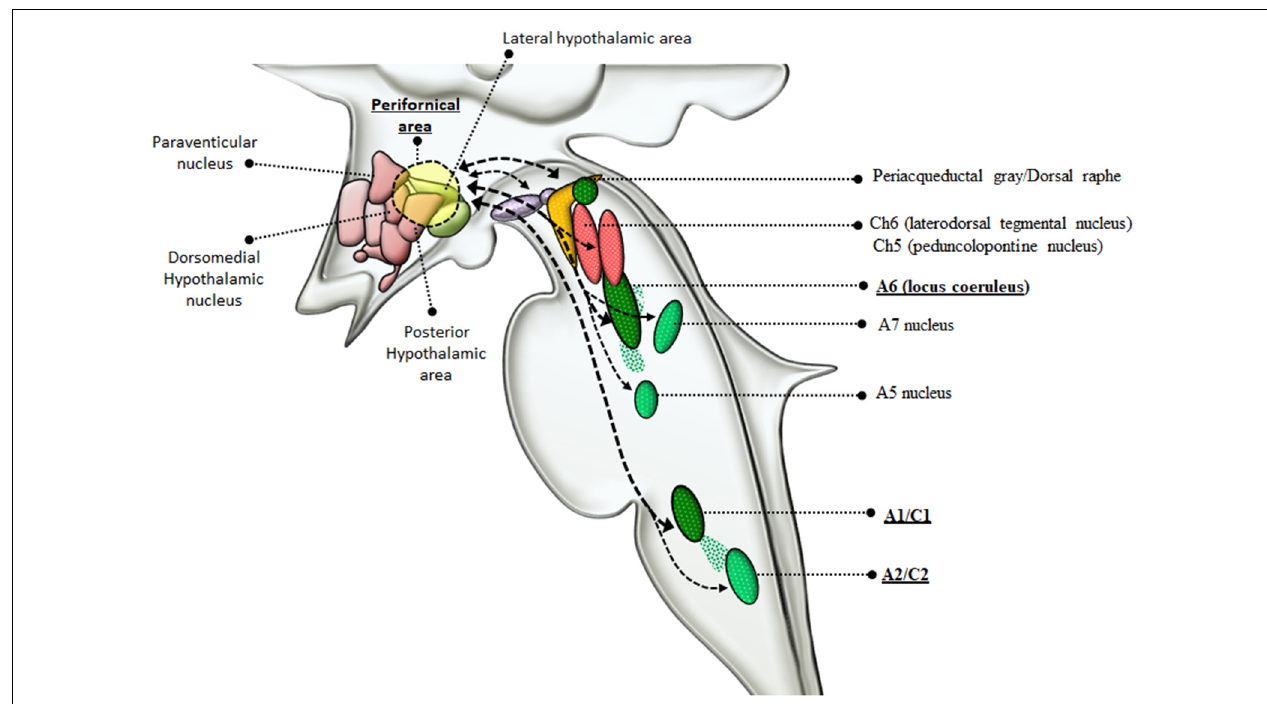
FIGURE 4 | Connections between reticular nuclei and orexin-containing perifornical neurons of the hypothalamus. Orexin-containing neurons are placed within the dorsolateral hypothalamus corresponding to the perifornical area. Orexin perifornical neurons are profusely connected with a number of brainstem RF nuclei including the PAG/dorsal raphe, VTA, Ch6, Ch5, A6, A5, A7, A1/C1, A2/C2 (Marcus et al., 2001; Sharf et al., 2010; Mahler et al., 2012). However, among these neuronal groups, orexins display the highest neuro-anatomical and pharmacological specificity with NE-containing neurons, as witnessed by the strong reciprocal connections with LC and A1/C1 nuclei (thick dashed connectors) and the abundance of orexin receptors in these nuclei (McCabe and Leibowitz, 1984; van den Pol et al., 2002; Bayer et al., 2005; Gompf and Aston-Jones, 2008; Li et al., 2015; Ritter, 2017). In the light of such connections with NE neurons, orexin-containing neurons are dragged in a variety of functions including, arousal, locomotion, feeding, reward, sensitization, motivation (Sakurai et al., 1998; Sakurai, 2007; Sakurai and Mieda, 2011). Since AMPHs are powerful NE releasers and they strongly activate orexin-producing neurons as well, it is likely that the strong connections between orexin and NE-neurons of the LC and A1/C1 are implicated in the effects induced by